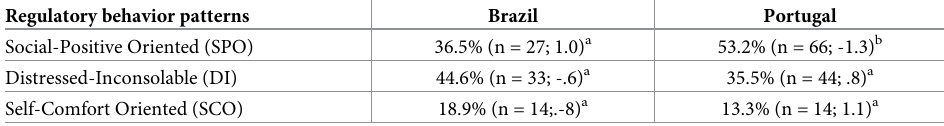
Table 3. Regulatory behavior patterns of infants during the FFSF at 3 months in the Brazilian and Portuguese samples. Regulatory behavior patterns